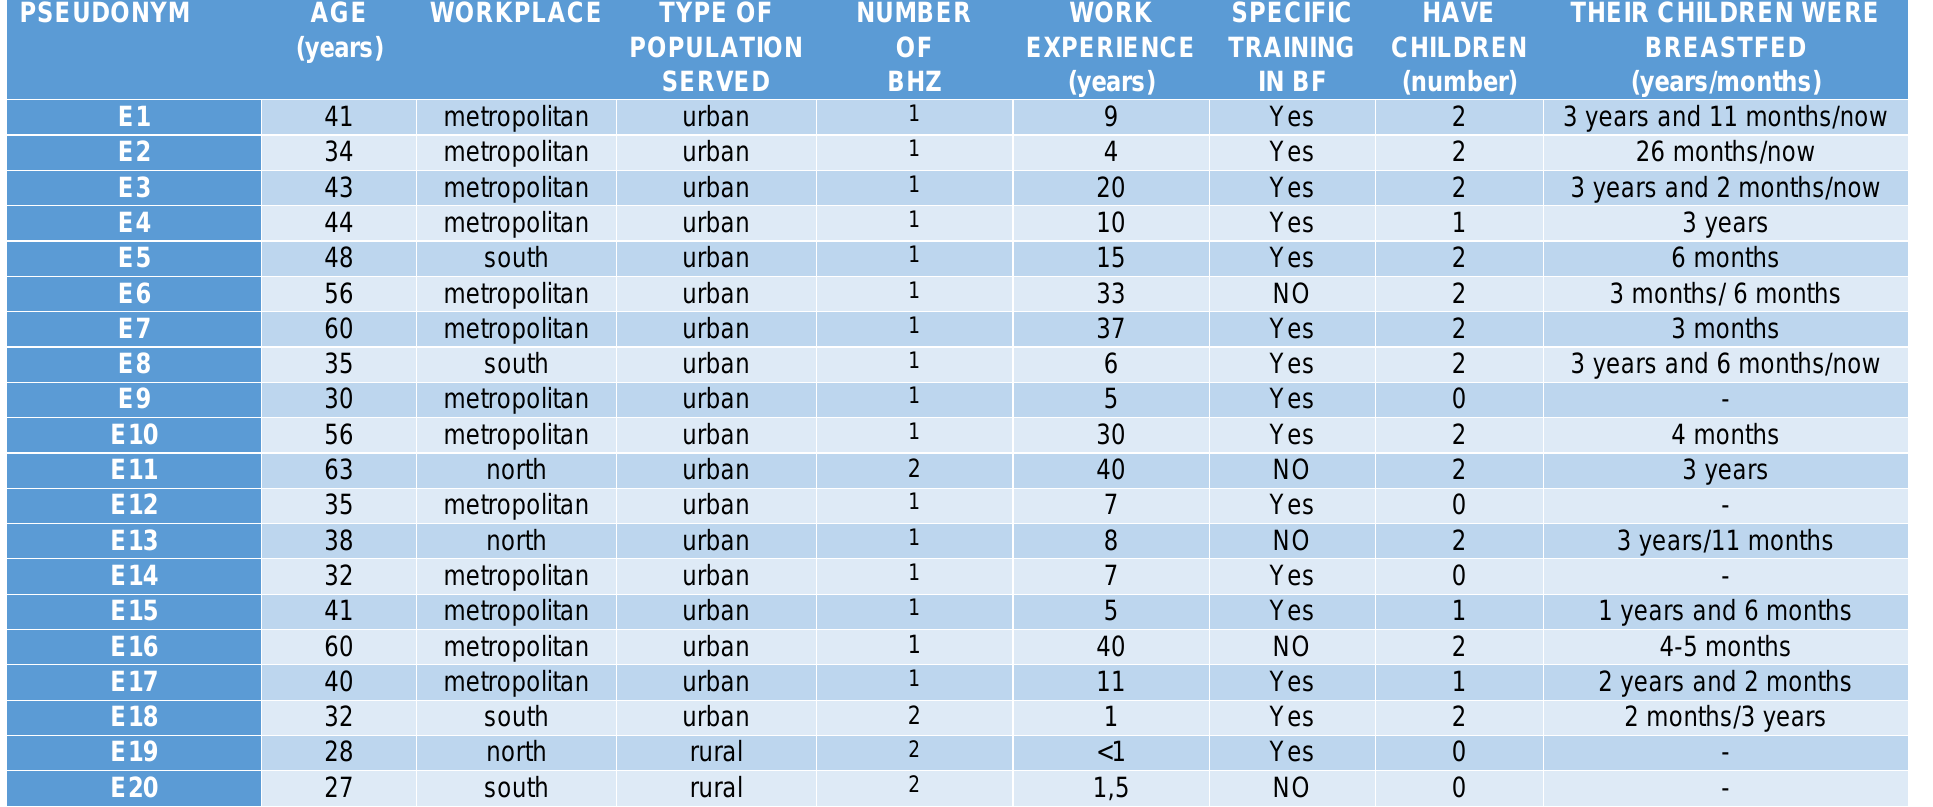
Figure A1. Profiles of Primary Care midwives.